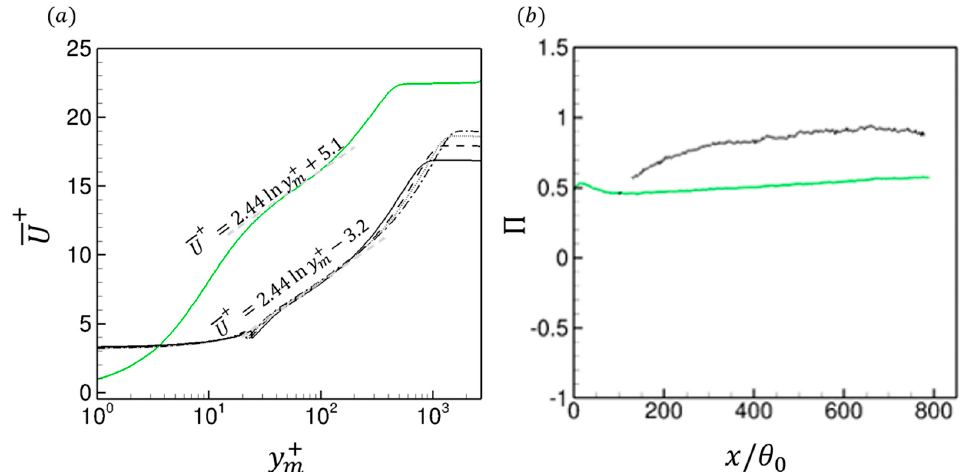
Figure 8. ( a ) Mean velocity profiles at select streamwise fetch locations using inner scaling for the rough-wall case. The logarithmic equations in ( a ) correspond to the dashed gray lines. Upstream of the STR step change (green), downstream of the step change (black). The x location of the profiles follow the legend from Figure 6. Note that the results for reference and the rough-wall cases are identical upstream of the step change at x = 42 θ 0 . ( b ) Streamwise variation of the wake strength parameter 𝛱.